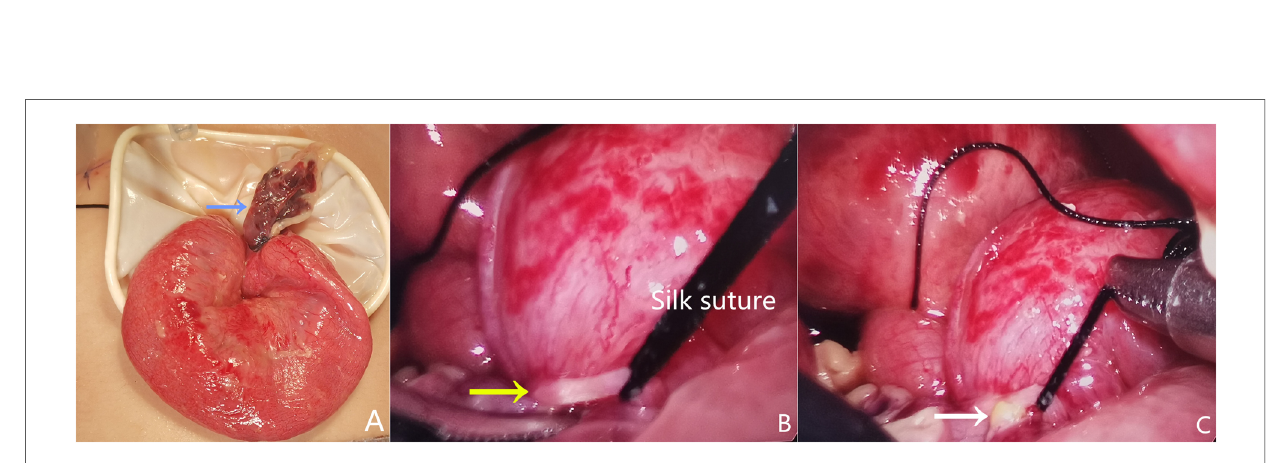
FIGURE 2 Intraoperative fi ndings revealed a necrotic Meckel diverticulum and laparoscopic transient occlusion ( A , blue arrow) associated with a concomitant fi brotic band ( B , yellow arrow) and occult perforation ( C , white arrow) in a 5-month-old boy with sepsis.